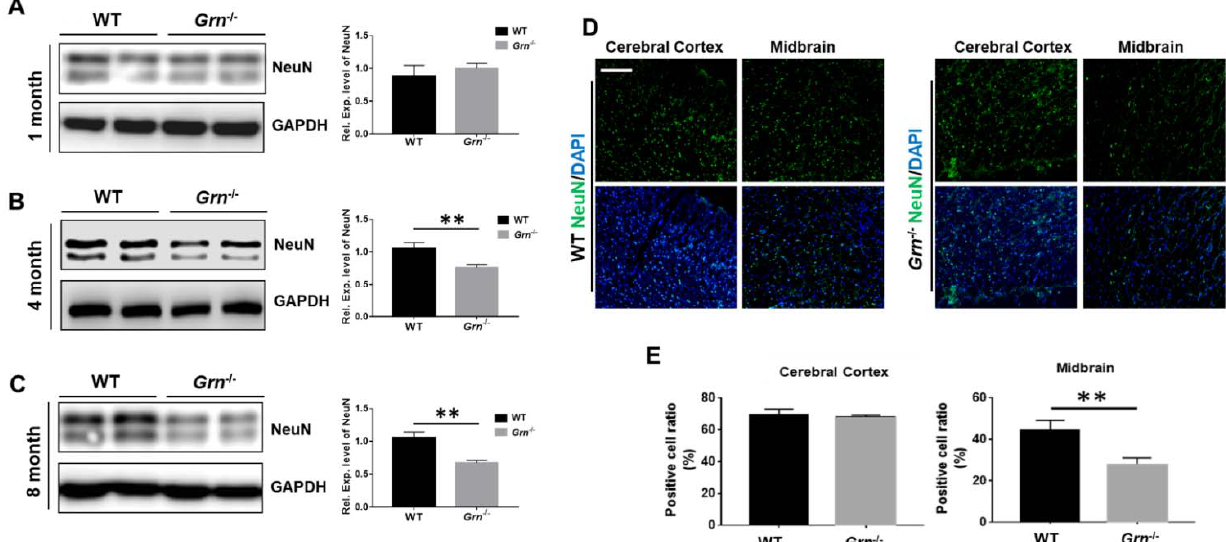
Figure 1. PGRN deficiency led to neuron loss. Brain tissues were collected from 1-month-, 4-month-, 8-month-, and 12-month-old WT mice or Grn − /– mice. 1-, 4-, and 8-month-old brain tissues were homogenized and lysed in lysis buffer, and then the tissue lysate was used to perform Western blotting. The 12-month-old brain tissues were sectioned and used for immunofluorescence staining. ( A ), ( B ), ( C ) Western blot analysis of NeuN in the 1-, 4-, and 8-month-old brain tissue of WT and Grn − /– mice. ( D ) Immunofluorescent staining of NeuN in 12-month-old brain tissue of WT or Grn − /– mice. ( E ) Statistical analysis of ( D ). Scale bar: 100 µ m. n = 3. Data presented as mean ± SD. ** p <